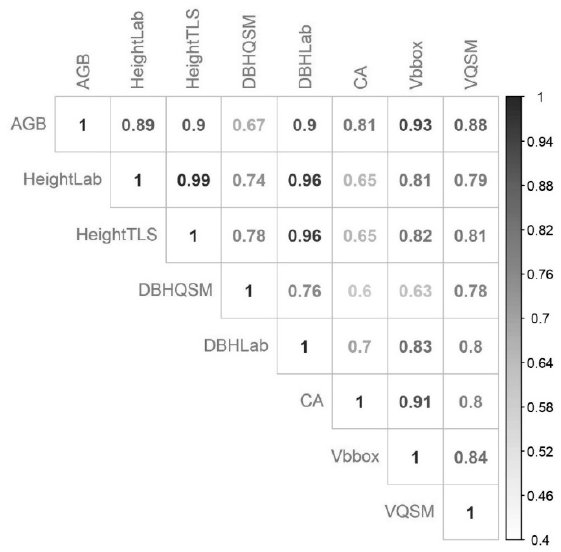
Figure 7. Correlation matrix between individual tree above ground biomass (AGB) and each predictor (lab-measured, terrestrial laser scanner (TLS) measured, or quantitative structure model (QSM)-derived), and between each pair of predictors. Stronger correlations are denoted with darker tone. Crown diameter is not included because it is equivalent to crown area. DBH = diameter at breast height, CA = crown area, Vbbox = bounding box volume, VQSM = QSM-derived volume.